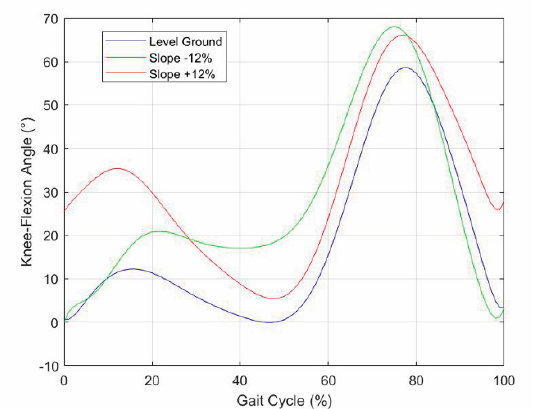
Figure 12 . Knee-flexion angle for three different longitudinal slopes of the walkway.